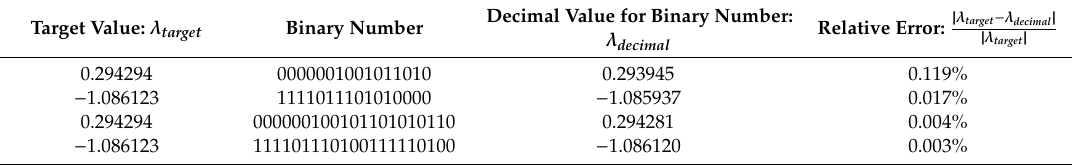
Table 3. Comparison of encoded binary numbers with target